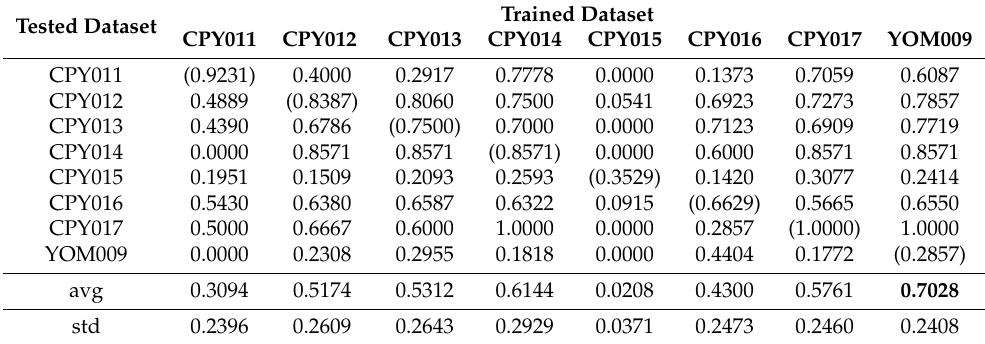
Table 7. The F1-scores of the MLP models when testing with the dataset from the same station (shown in the bracket) and different